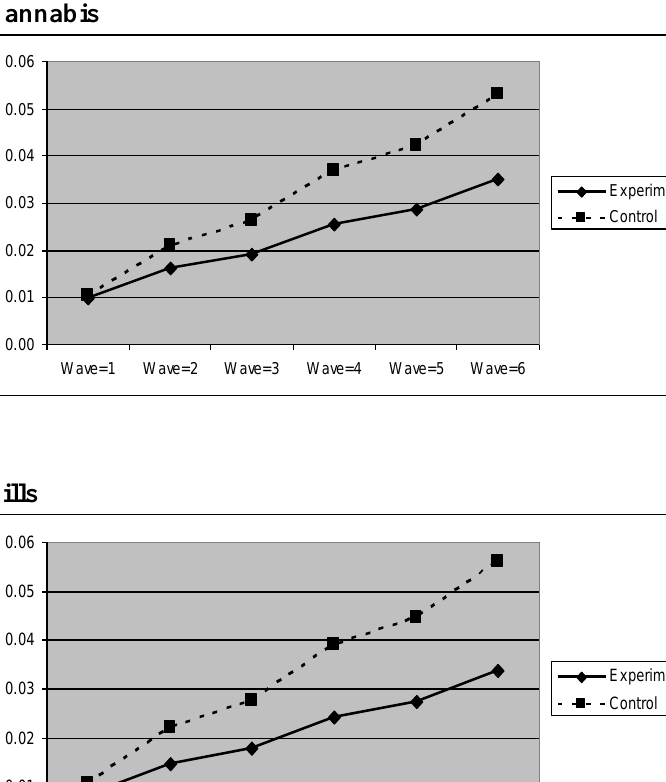
FIGURE 14 . Growth trajectories of the experimental group (Tier 1 participants who perceived the program as effective) and control group using the item score of taking pills as the outcome indicator.